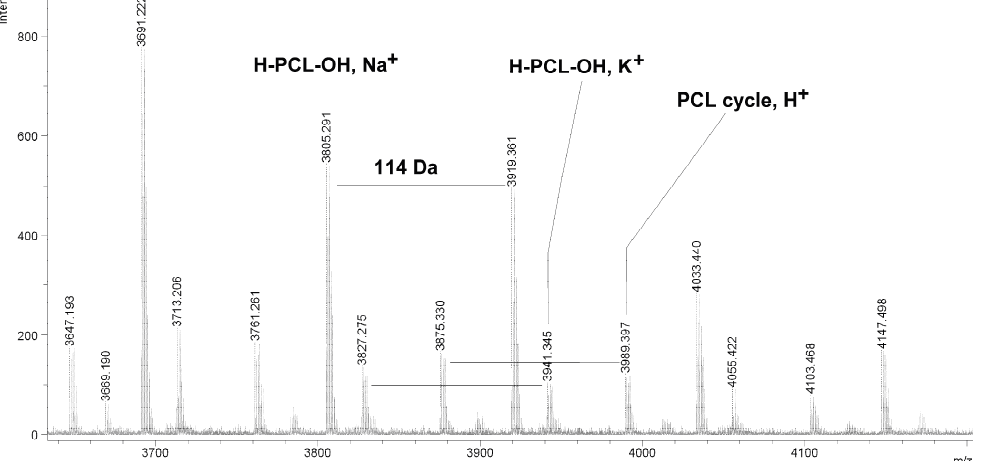
Figure 4. MALDI TOF MS spectrum of PCL obtained in the presence ZnEt 2 /GAc catalytic system ( PCL-3